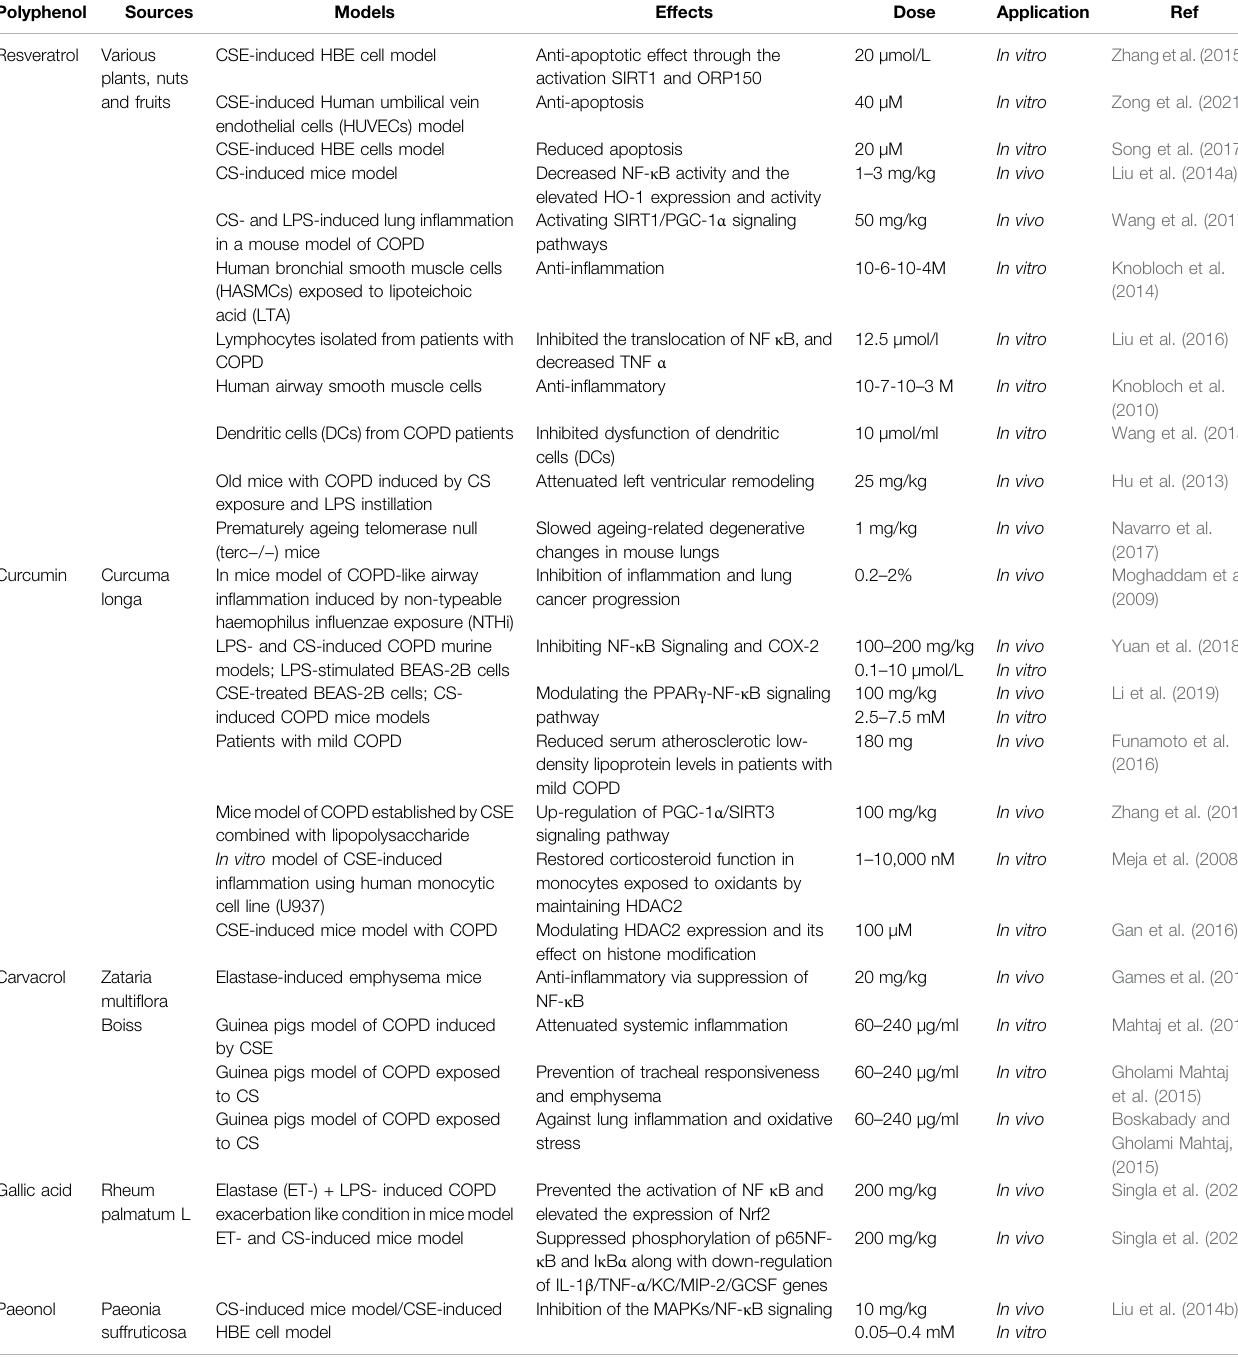
TABLE 2 | The effects of polyphenol on